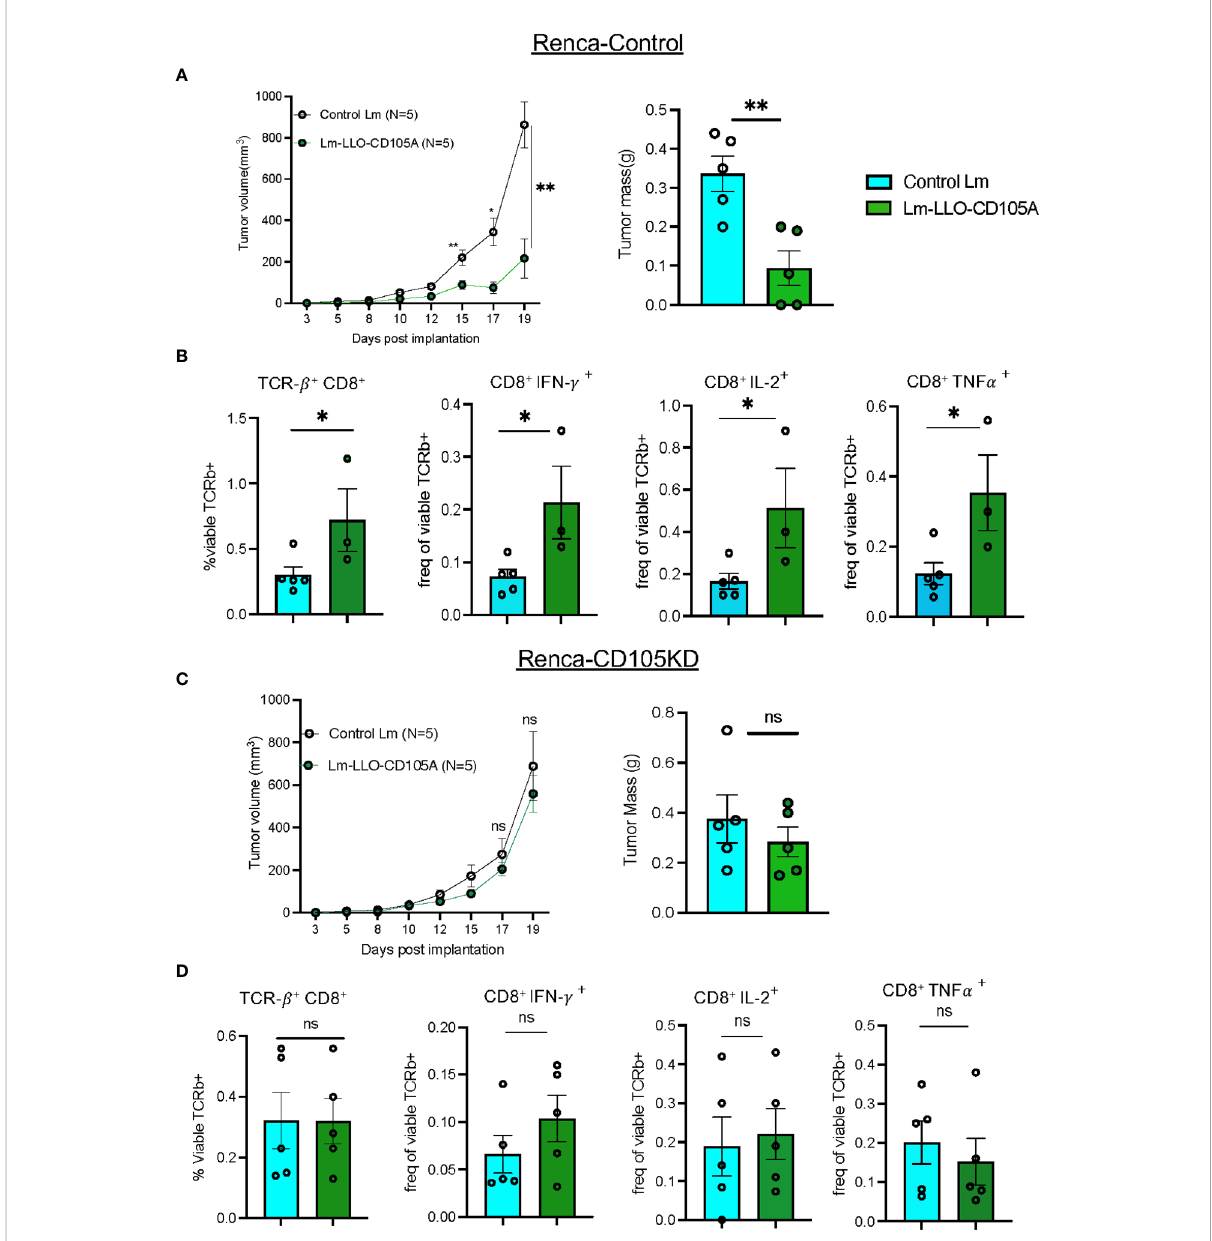
FIGURE 7 Tumoral CD105 is a robust antigenic target for Lm-LLO-CD015A directed effect. (A) Longitudinal tumor growth curve and fi nal tumor mass for Renca-Control tumors. (B) CD8 + T cell population and cytokine production in Renca-Control group. (C) Longitudinal tumor growth curve and fi nal tumor mass for Renca-CD105KD. (D) CD8 + T cell population and cytokine production in Renca-CD105KD group. (n=5/group). Data were analyzed using unpaired t-test. *P < 0.05, **P < 0.01. All error bars are shown as mean ± SEM. ns, not signi fi